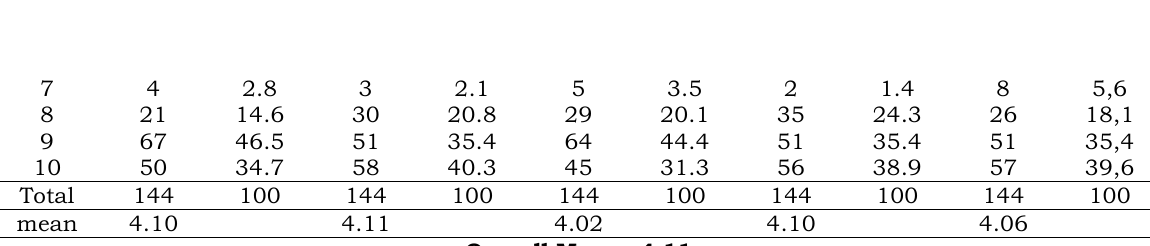
Table 3 portrayed student responses toward instrumental